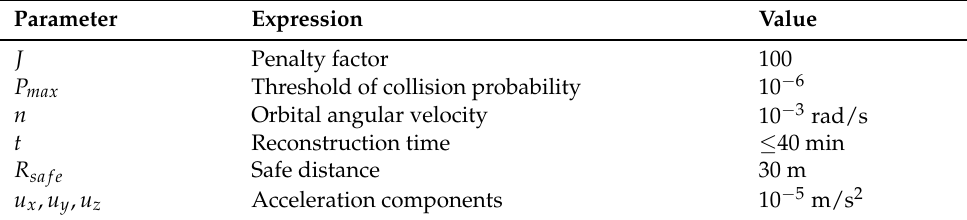
Table 6. Parameters of path